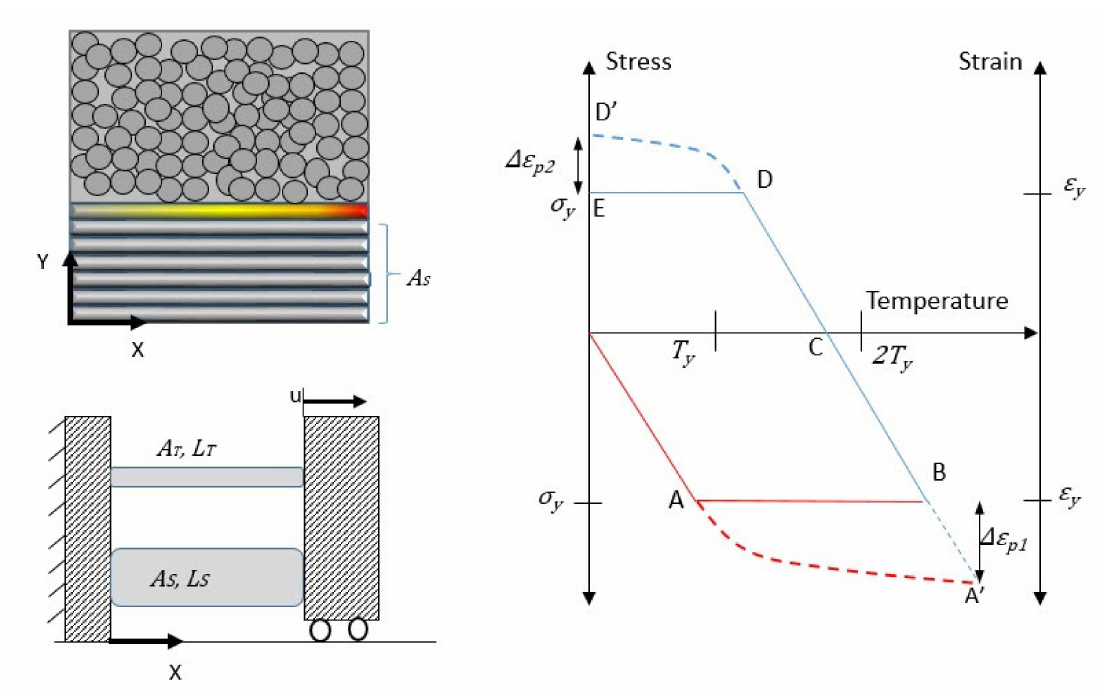
Figure 19. RS formation mechanism with the bar model analogy.